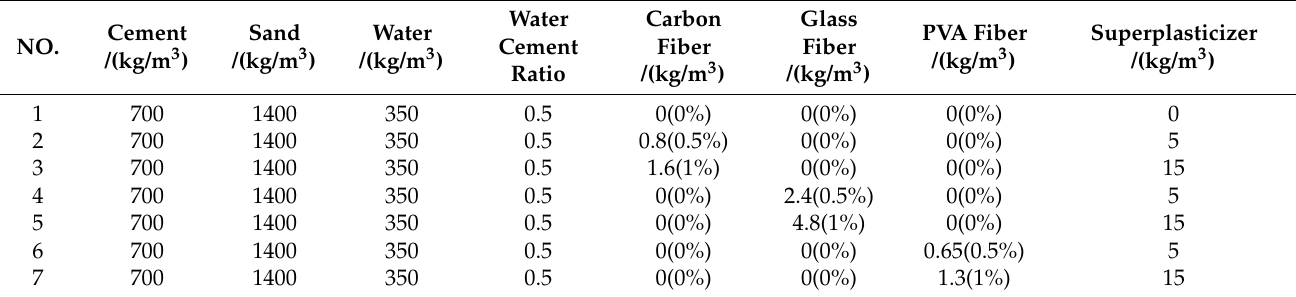
Table 4. Concrete mix design.